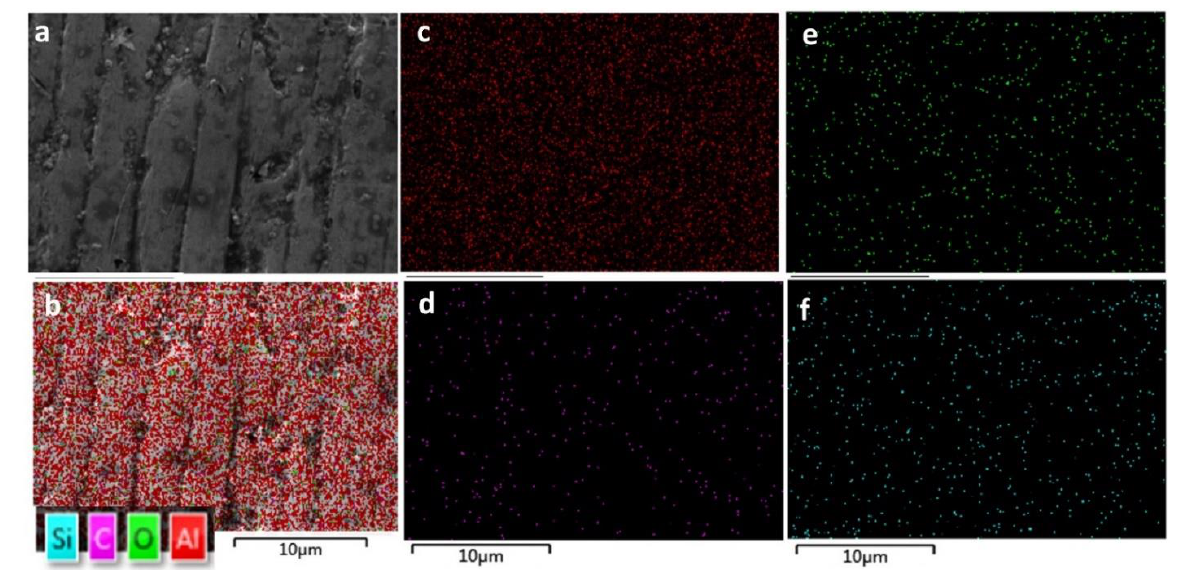
Figure 10. ( a ) Alumina wt % 99.5, silicon carbide wt % 0.5 at 160 W laser power. ( b ) EDS map of Si, C, O and Al; ( c ) EDS map of Al; ( d ) EDS map of C; ( e ) EDS map of C; and ( f ) EDS map of Si of the same article.